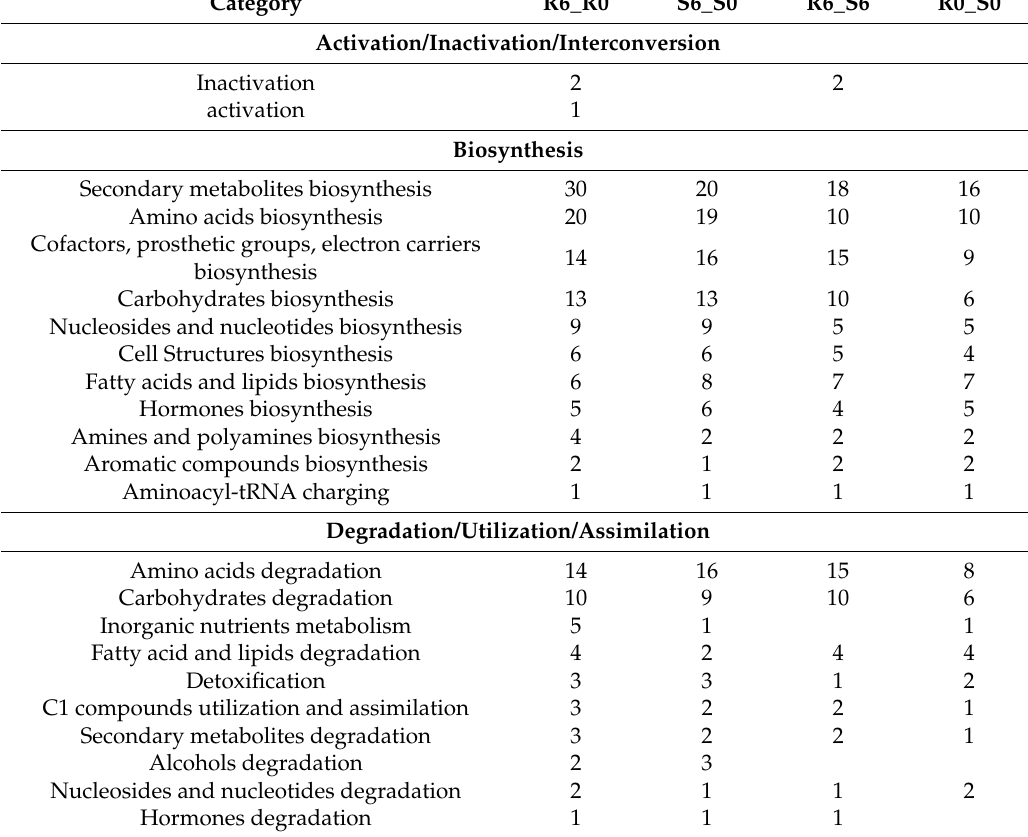
Table 1. Number of the differentially regulated metabolic pathways in response to SBPH